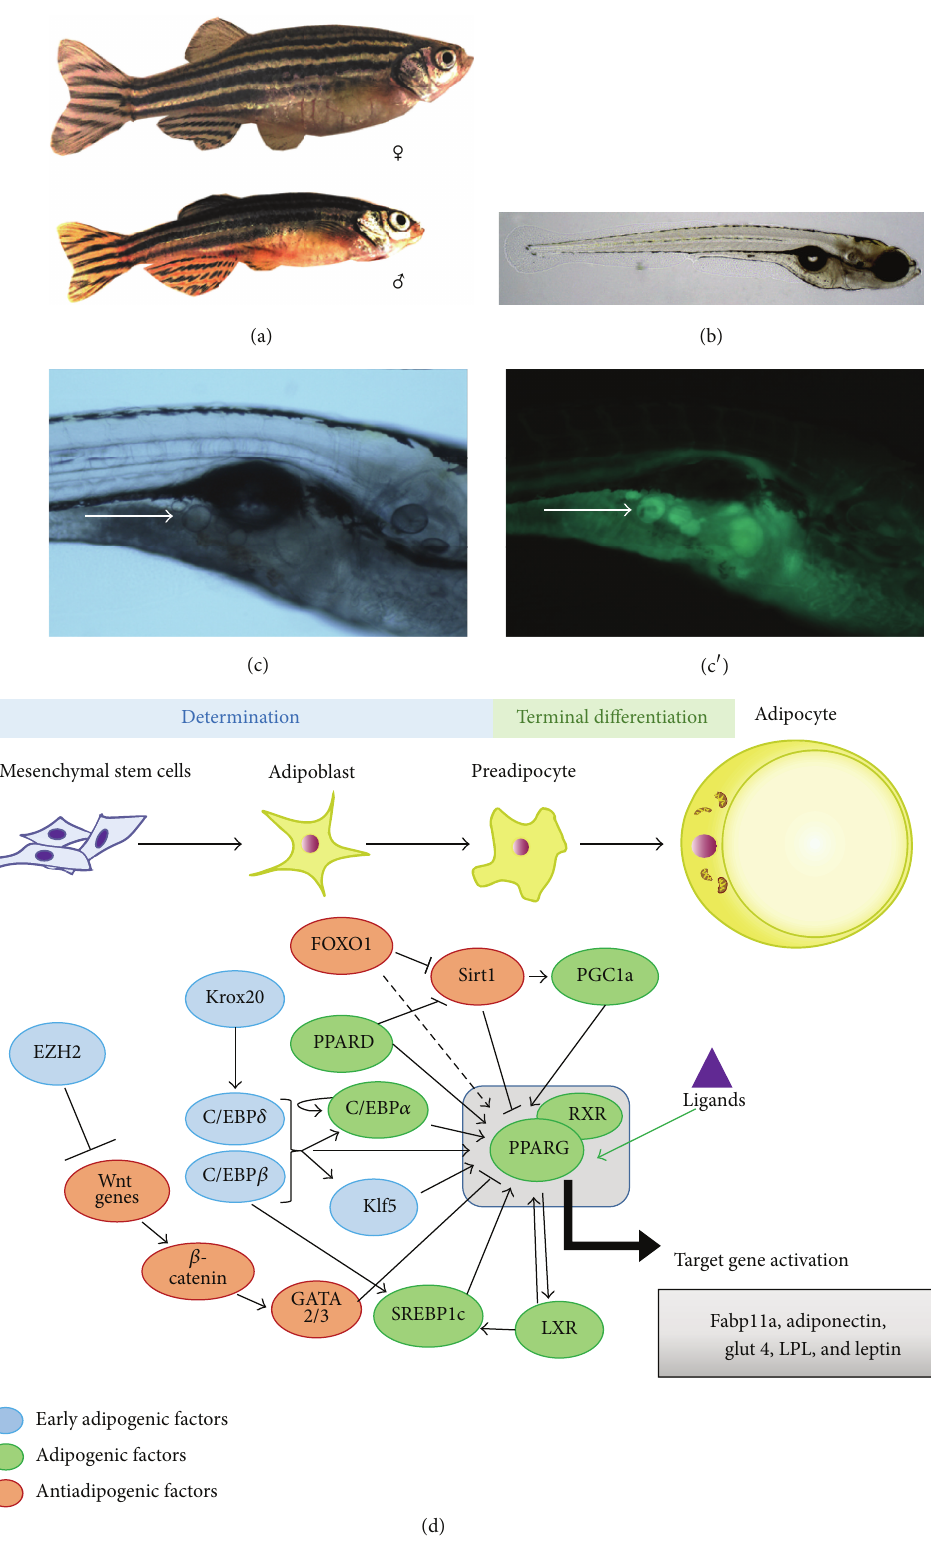
Figure 1: (a) An adult female and male zebrafish. (b) Developing zebrafish larvae (15dpf). (c + c 󸀠 ) A transmission light image of adipocytes in developing larvae (15dpf) (left) and a fluorescent image after staining lipids with LipidGreen (right). (d) Transcriptional network of factors important for adipocyte differentiation in zebrafish and